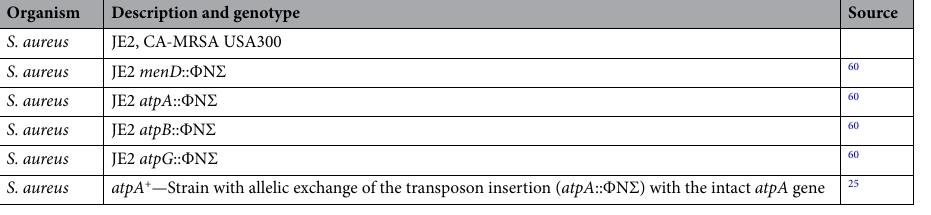
Table 1. Strains and mutants